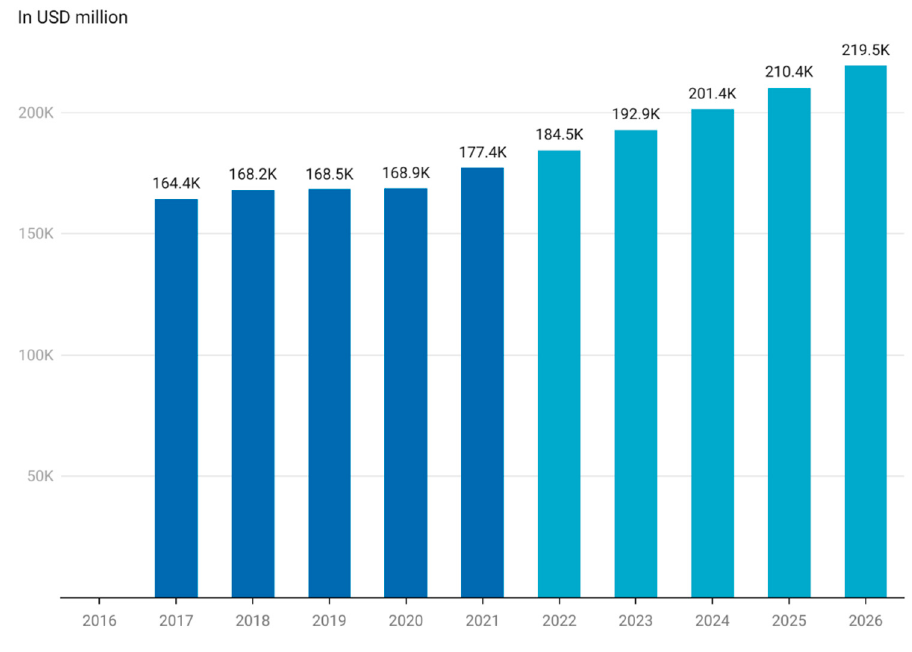
Figure 1. Market size of functional food worldwide (Euromonitor International, a market research provider (2022), (in USD million). This figure was made by the authors with raw data obtained from Euromonitor. Approval for use of data has been obtained from Euromonitor